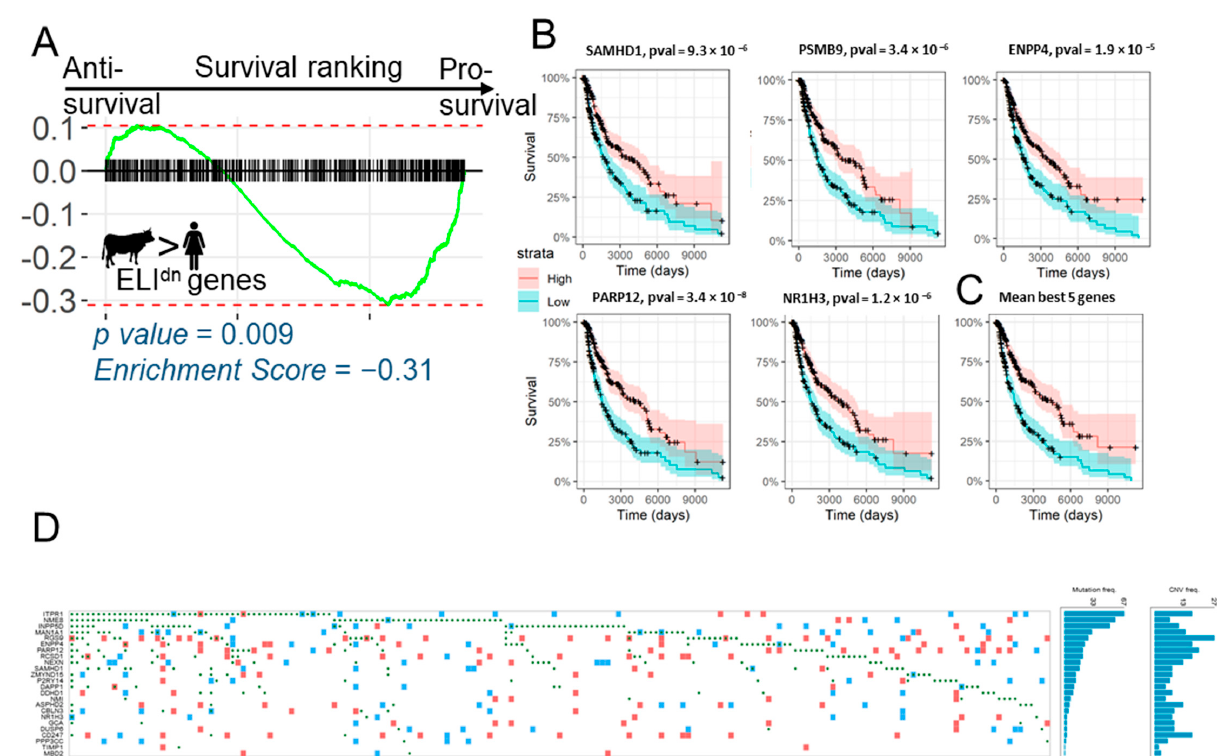
Figure 3. Loss of expression of ELI dn genes reduces melanoma patient survival. ( A ) GSEA plot of the ranking of the top 500 ELI dn genes in the order of their effect of survival prognosis. ELI dn genes are significantly enriched for pro-survival genes. ( B ) Five of the most pro-survival genes from the leading edge of (A) are shown, with their effect on survivability, with the averaged effect (median-normalized z-score of their expression) shown in ( C , D ) Mutation and copy number variations in the ELI dn , pro-survival leading edge genes from Figure 3a. Figure generated from TCGA Oncogrid. The green dots correspond to single nucleotide polymorphisms, and red and blue squares correspond to the gain and loss in copy number variation, respectively.